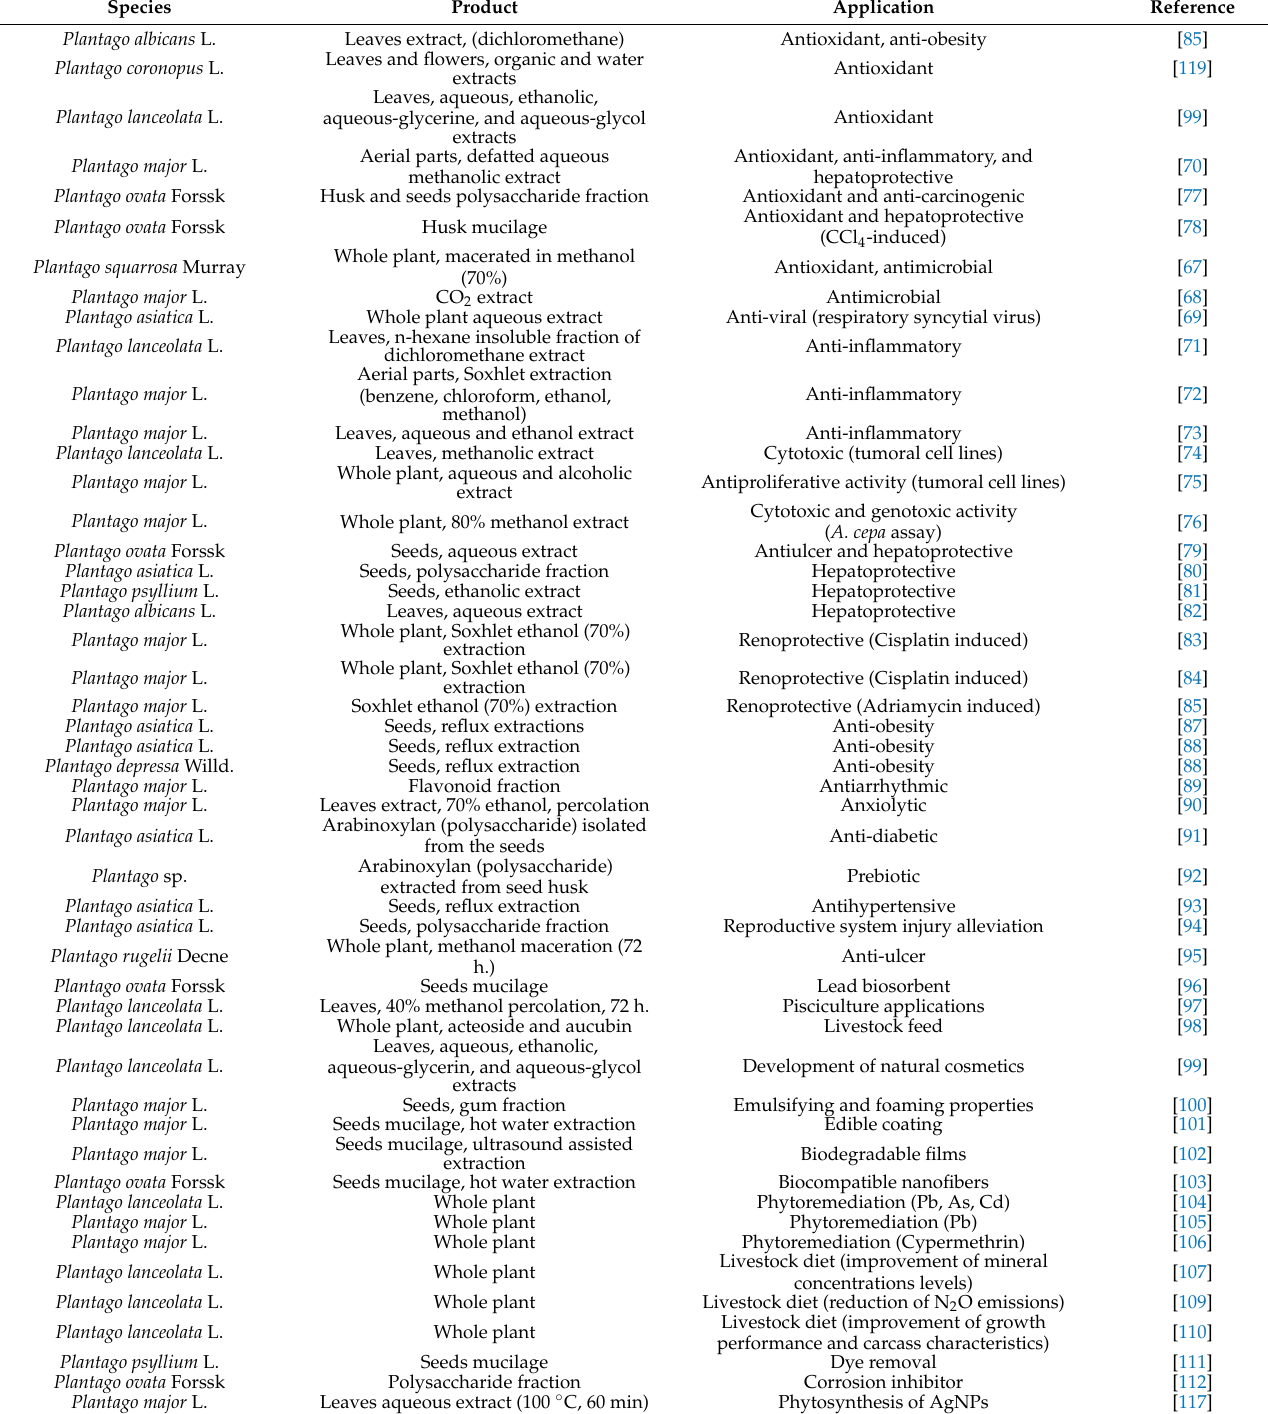
Table 3. Examples of Plantago sp. Applications—starting point for future P. media